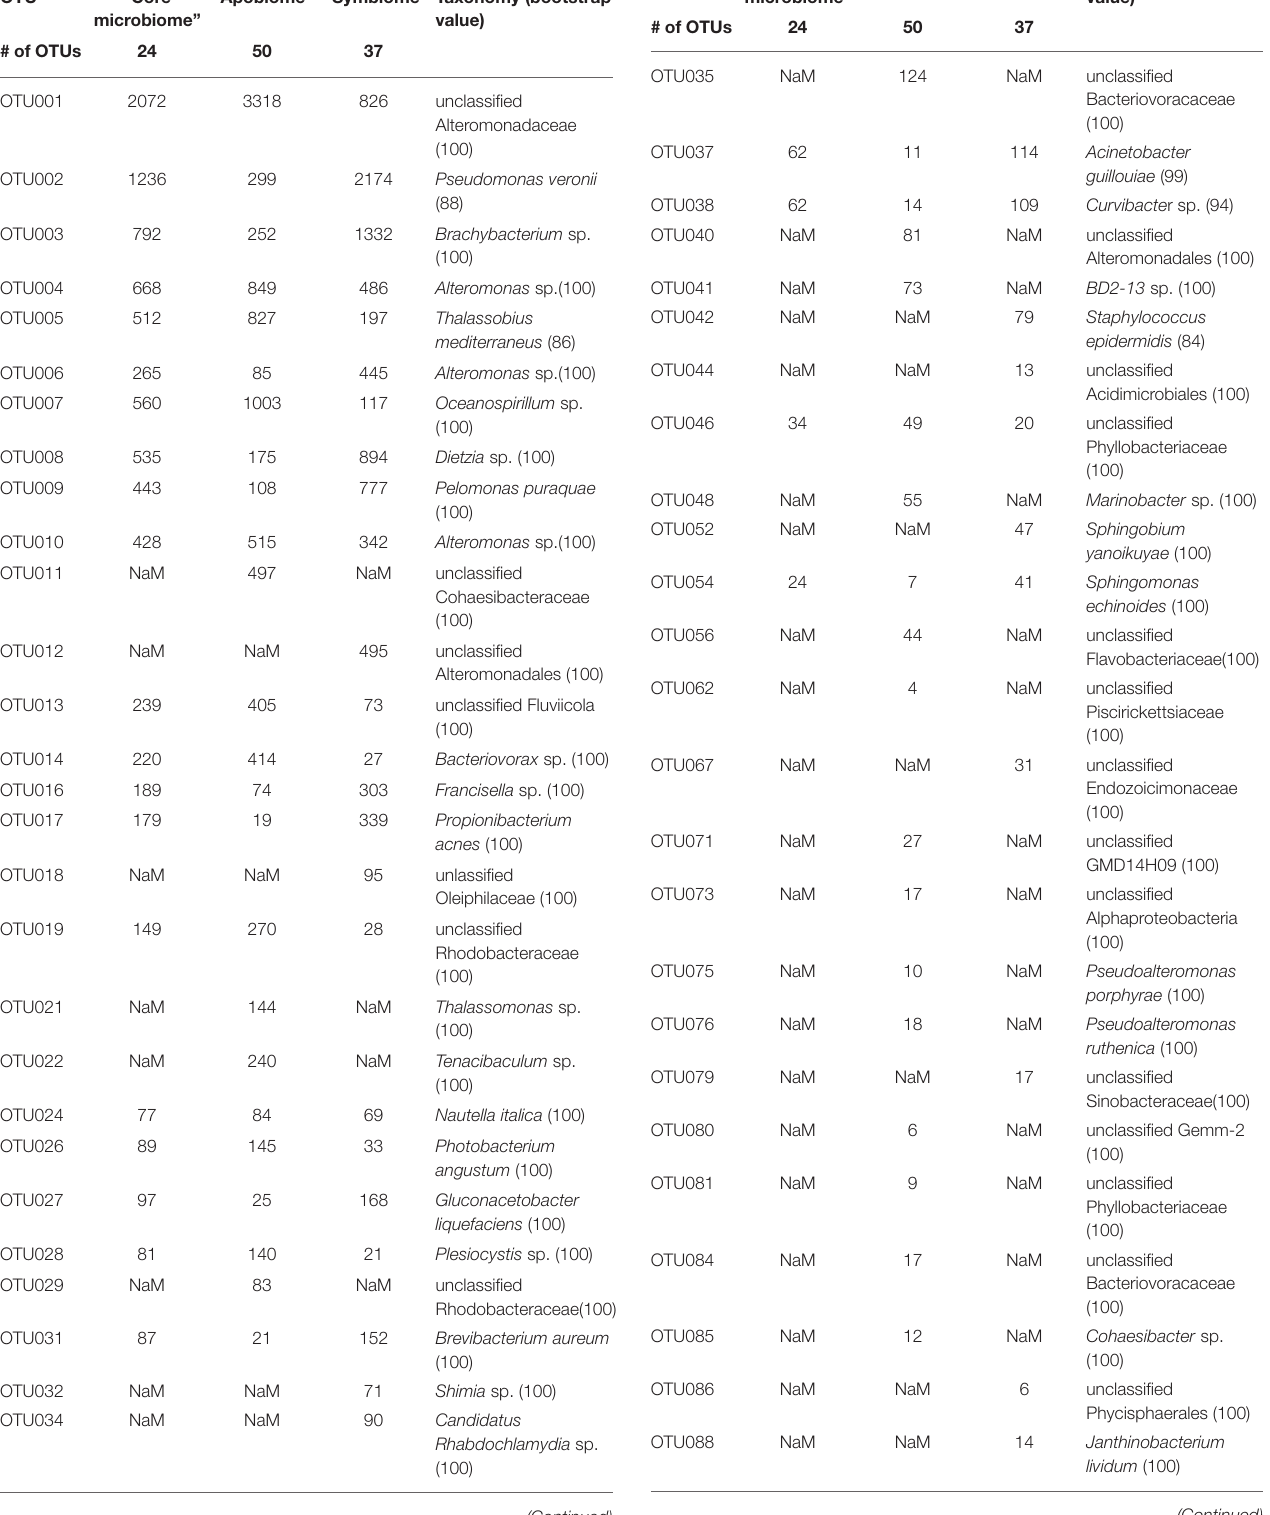
TABLE 2 | Aiptasia “core microbiome”, “apobiome” (aposymbiotic microbiome), and “symbiome” (symbiotic microbiome). OTU “Core “Apobiome” “Symbiome” Taxonomy (bootstrap microbiome”